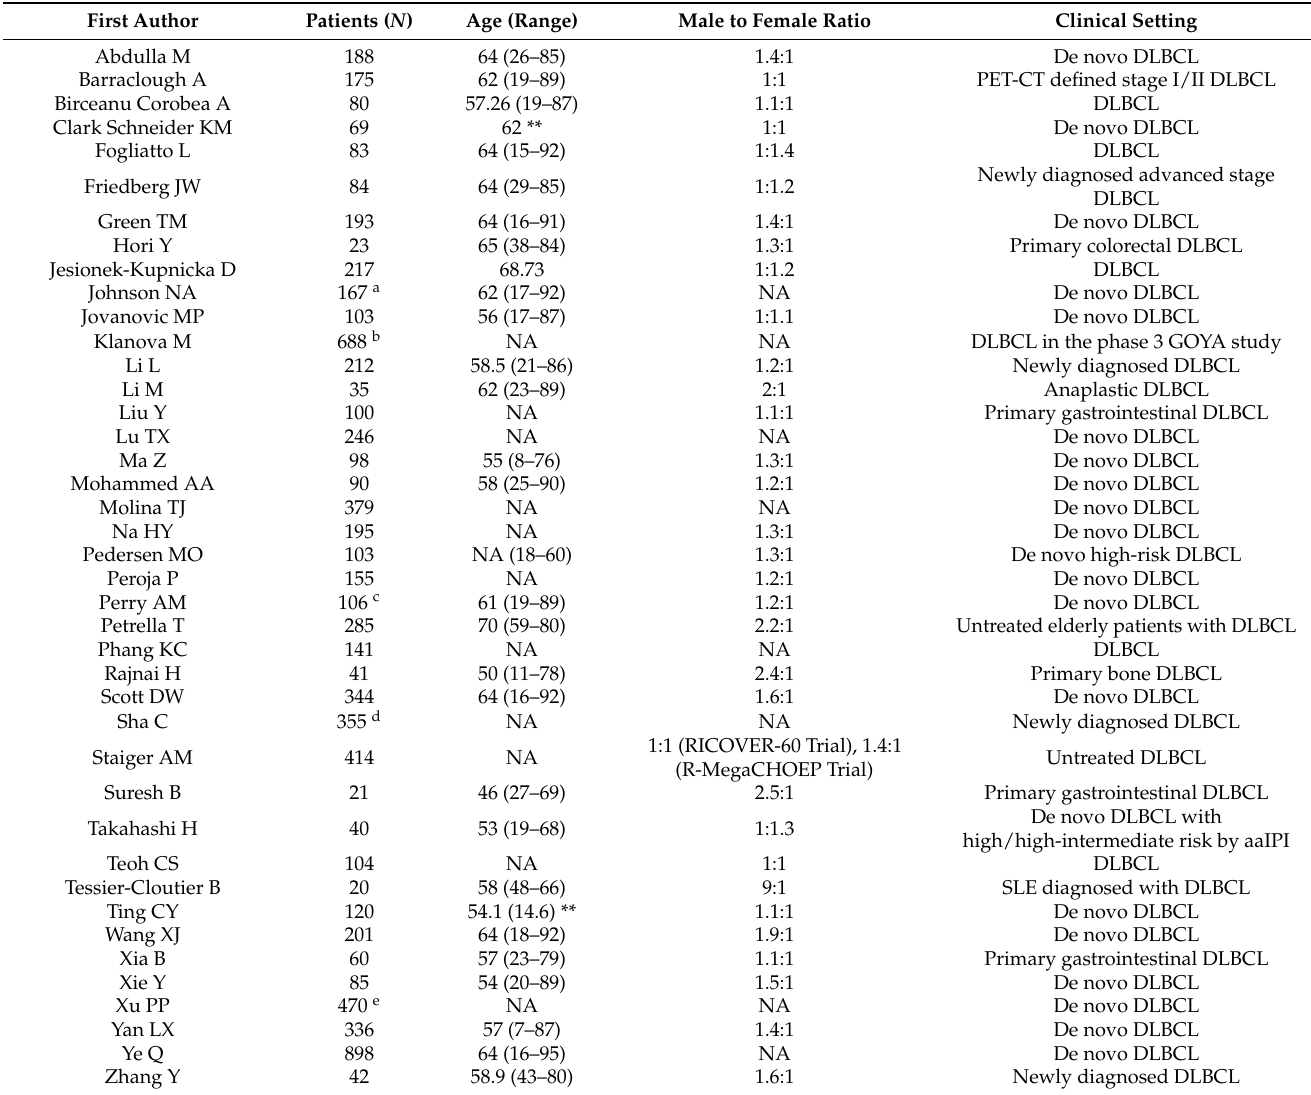
Table 2. Patient